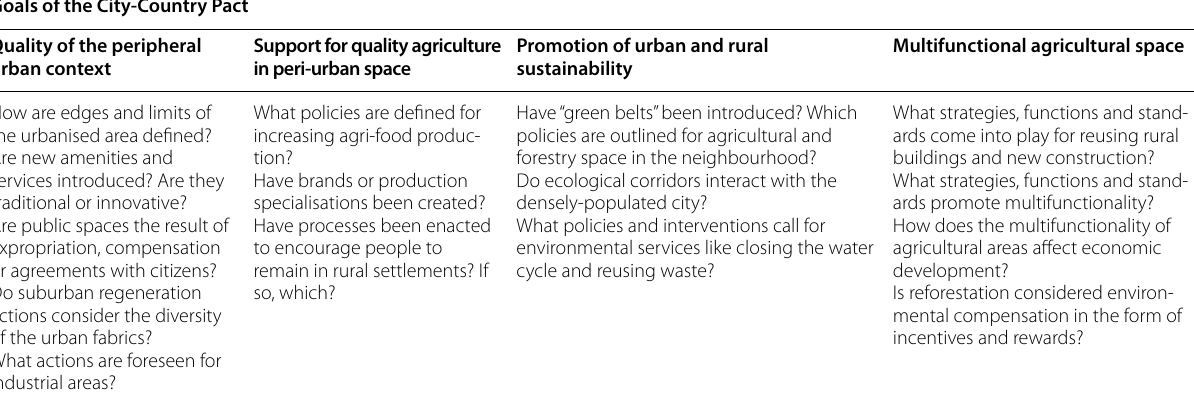
Source: Own elaboration based on contents of Guidelines for the City-Country Pact: redevelopment of suburbs and peri-urban agricultural areas (PPTR’s elaborate 4.4.3)